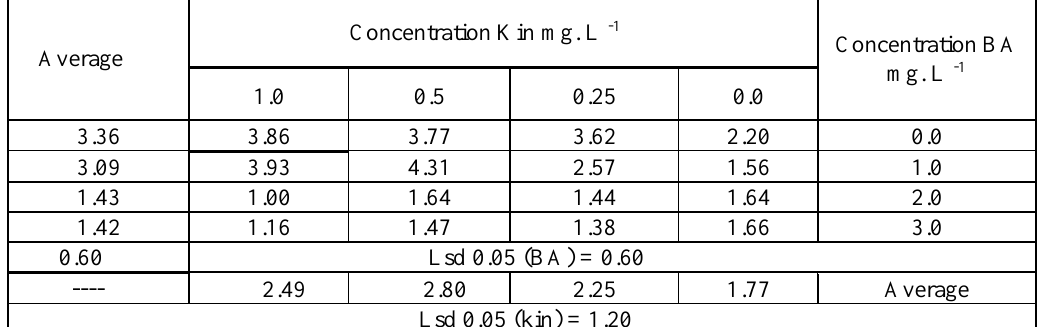
Table 3. The effect of BA and Kin and their interaction between on the average shoot length (cm) of stevia plants invitro after four weeks of